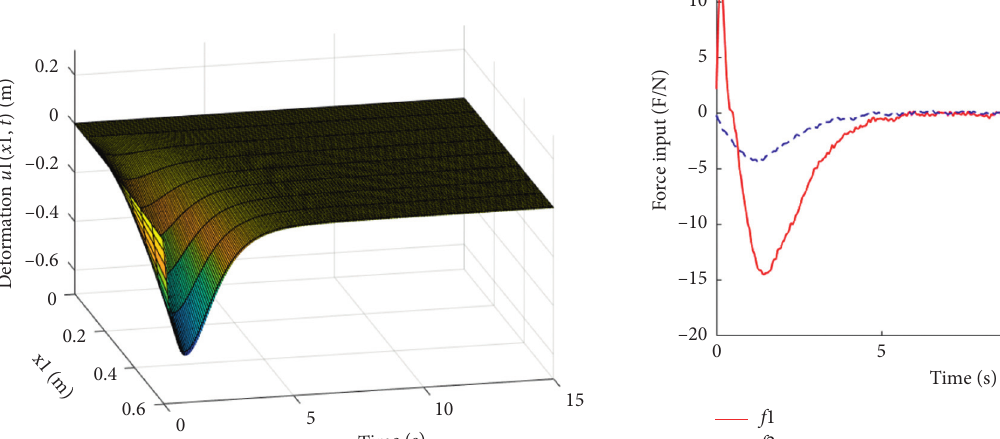
Figure 5: Deformation of the first link.